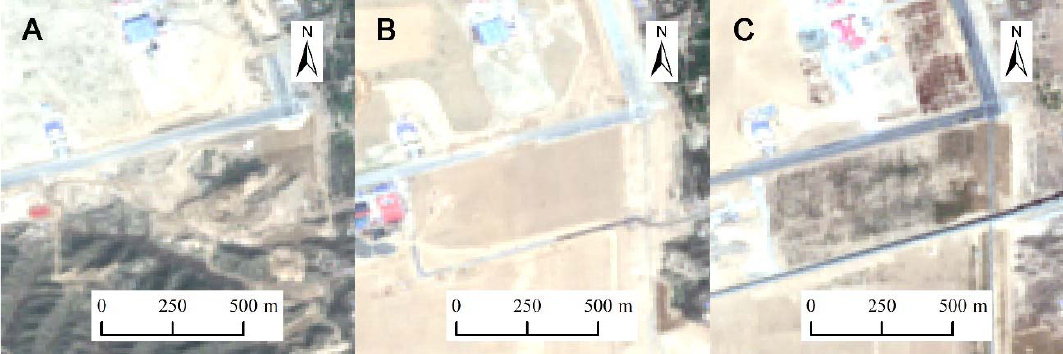
Figure 14. Changes in the research area (( A ) is on 12 October 2018; ( B ) is on 4 July 2019; ( C ) is on 4 May 2022). 4 May